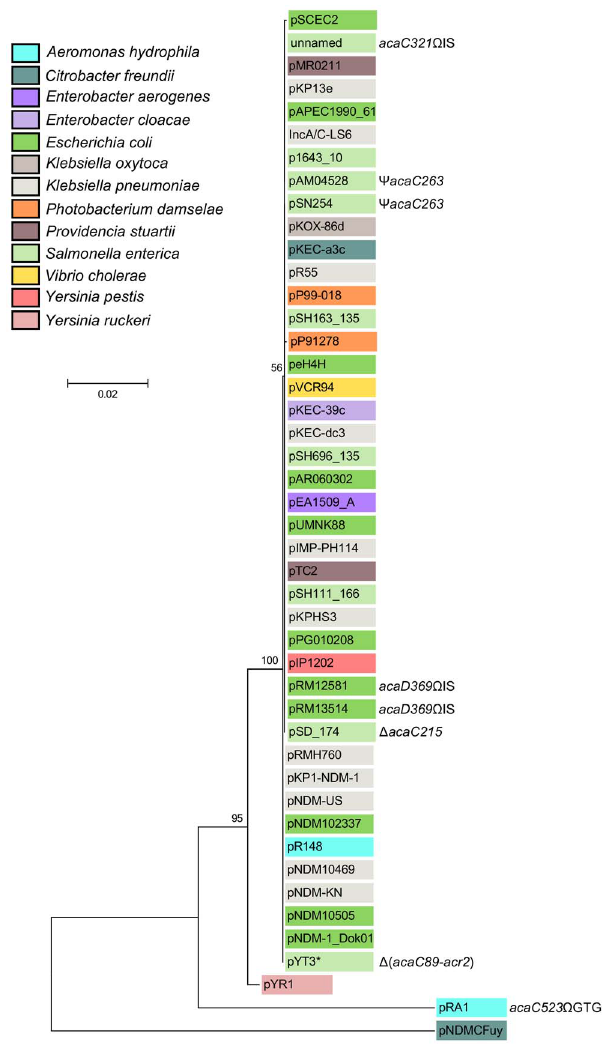
Figure 2. Molecular phylogenetic analysis of the acr1 - vcr147 - acaDC - acr2 locus by Maximum Likelihood method. The evolu- tionary history was inferred by using the Maximum Likelihood method based on the Kimura 2-parameter model [61]. The tree with the highest log likelihood ( 2 5461.6977) is shown. The percentage of trees in which the associated taxa clustered together is shown next to the branches. A discrete Gamma distribution was used to model evolutionary rate differences among sites (5 categories ( + G, parameter=0.6567)). The tree is drawn to scale, with branch lengths measured in the number of substitutions per site. The analysis involved 45 nucleotide sequences (Table S2). Codon positions included were 1st + 2nd + 3rd + Noncoding. There were a total of 2469 positions in the final dataset. Evolutionary analyses were conducted in MEGA6 [58]. The background color of each leaf indicates the original host species from which each plasmid was isolated. Insertions ( V ), deletion ( D ) and frameshift ( Y ) mutations are indicated where appropriate. *, Although pYT3 shares sequence identity with the IncA/C plasmids, it lacks an IncA/C-specific replication initiation gene ( repA ) and contains an IncFIB replicon instead (Figure